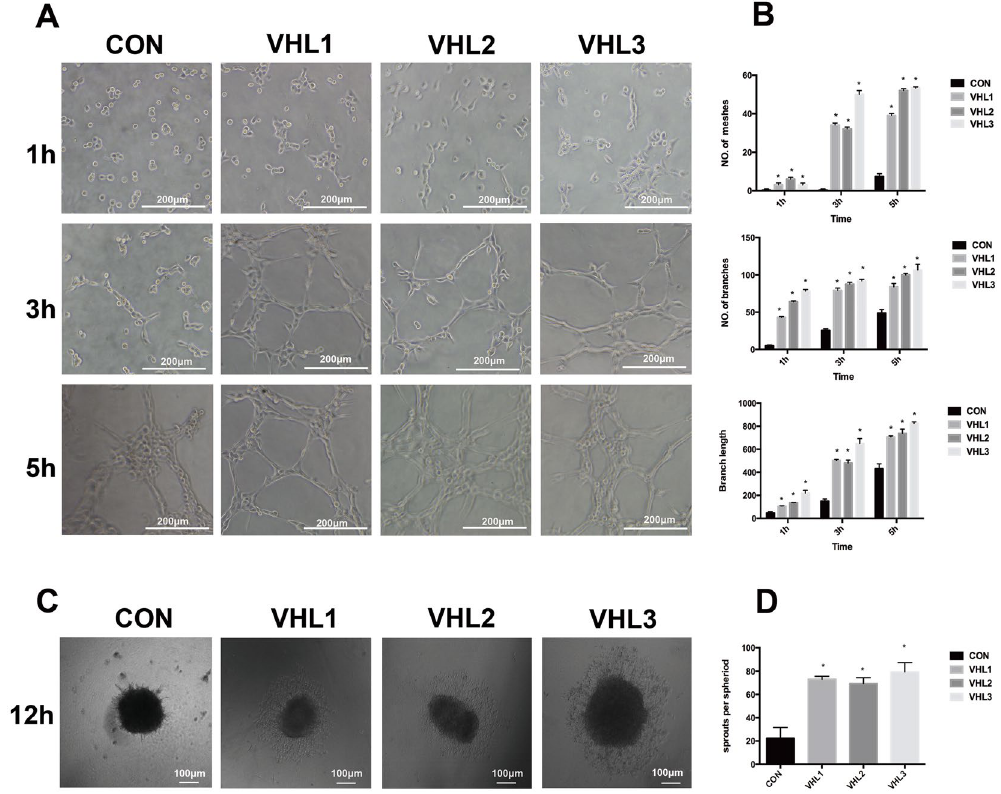
Figure 3. The effect of VHL gene knockdown on angiogenic ability of HUVEC cells in matrigel-based capillary formation assay and spheroid sprouting assay. ( A ) HUVEC cells from VHL knockdown groups exhibited a marked increase of capillary formation compared with control groups. At 1 hour, all cells did not form tube- structure. At 3 hours, VHL-silenced HUVEC exhibited the type of tube-structure while control cells did not. At 5 hours, all cells exhibited the type of tube-like structure with different morphologies, especially for typical features in VHL-silenced HUVEC cells (bar = 200 μ m). The quantification data of tube formation assay was shown in ( B ). ( C ) Representative images of spout outgrowth after 12 hours in control and VHL-silenced HUVEC spheroids (bar = 100 μ m). The length of the sprouts was measured and analyzed in ( D ), * represent P <